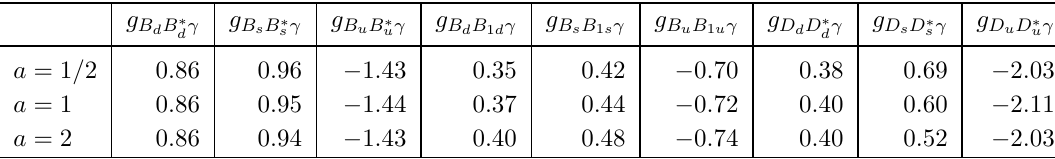
Table 5 . Values of the coupling for different values of the duality parameter a (cf. section 3.4.1 and (3.17)). The majority of couplings show little dependence on the duality parameter a . Notable exceptions are the neutral B 1 -couplings and the charged D ∗ -couplings. This does not come as a surprise as precisely those are plagued by, unfortunate, cancellations in the perturbative contribution of the Q b,c - and Q q -parts (cf. end of section 3.5.1 for